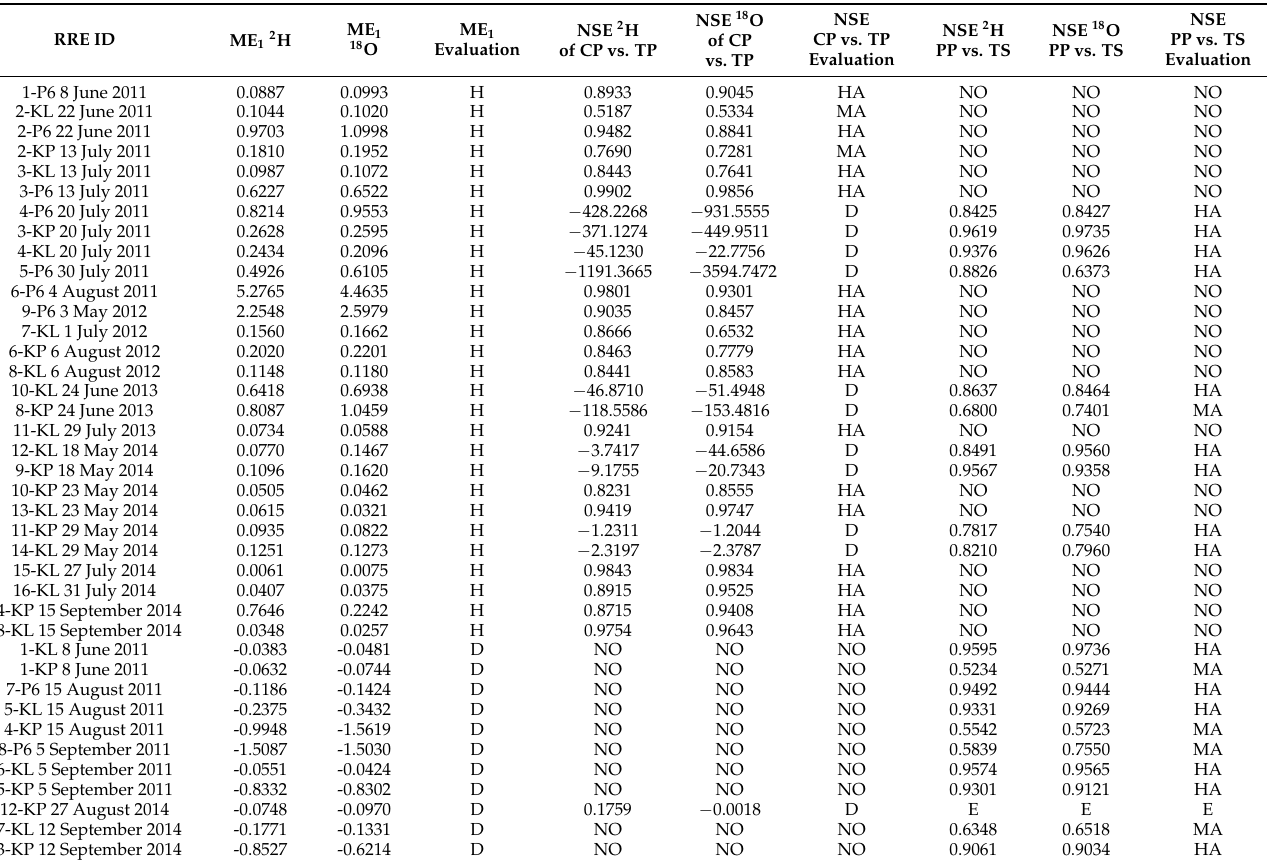
Table 4. Comparison of separation based on precipitation temperature with that based on precipi- tation isotopes and comparison of separation based on soil temperature with separation based on isotopes in a previous precipitation